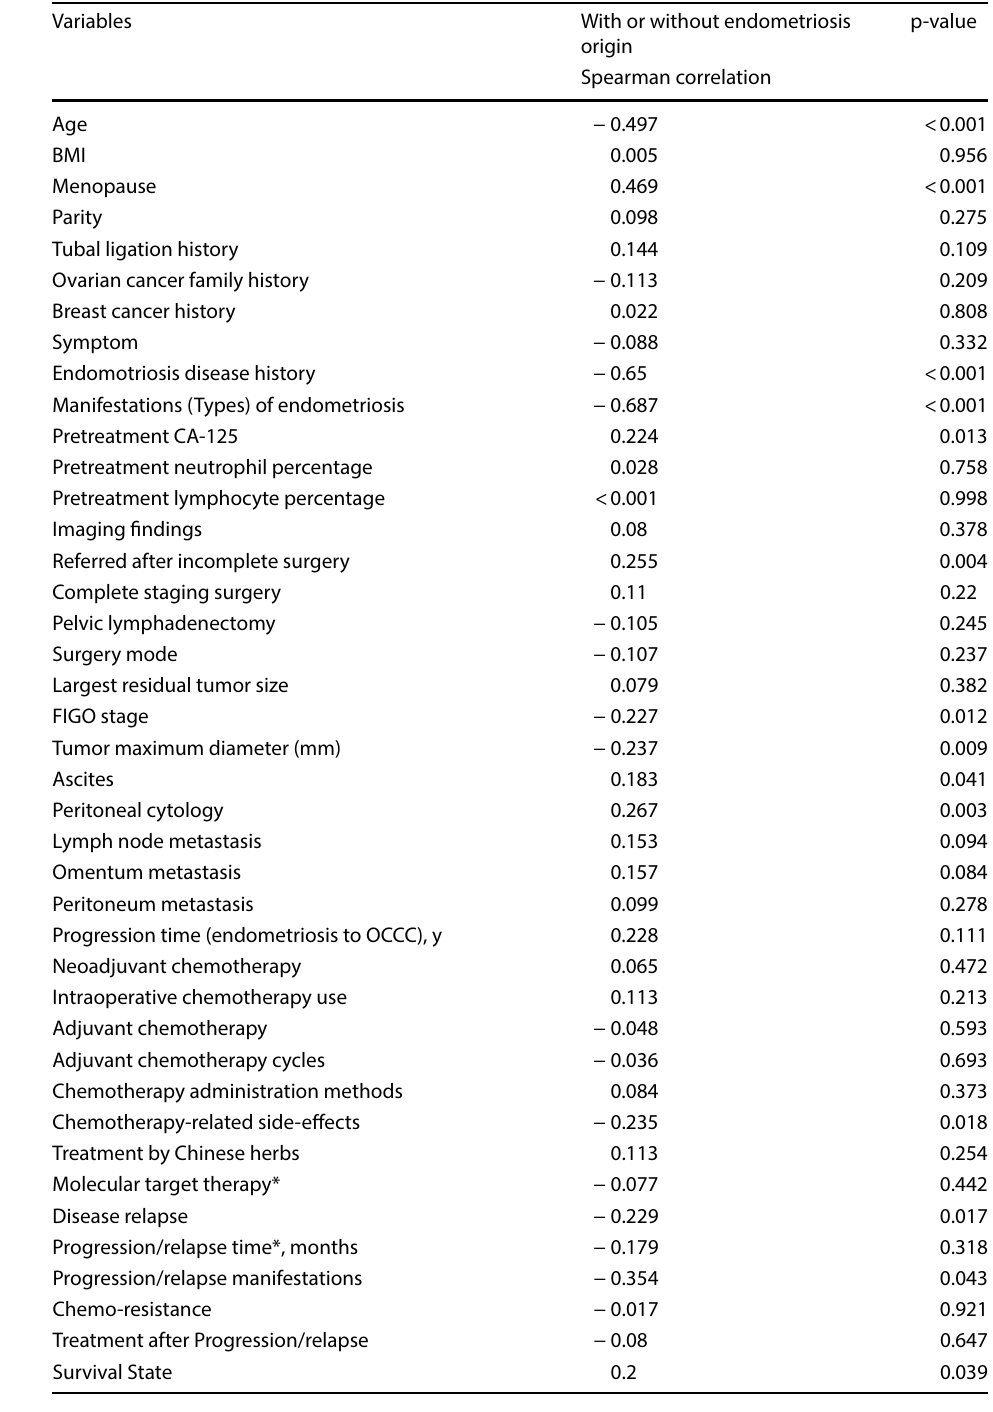
Table 6 Spearman analysis of correlation between endimetriosis origin and clinicopathological characteristics of OCCC